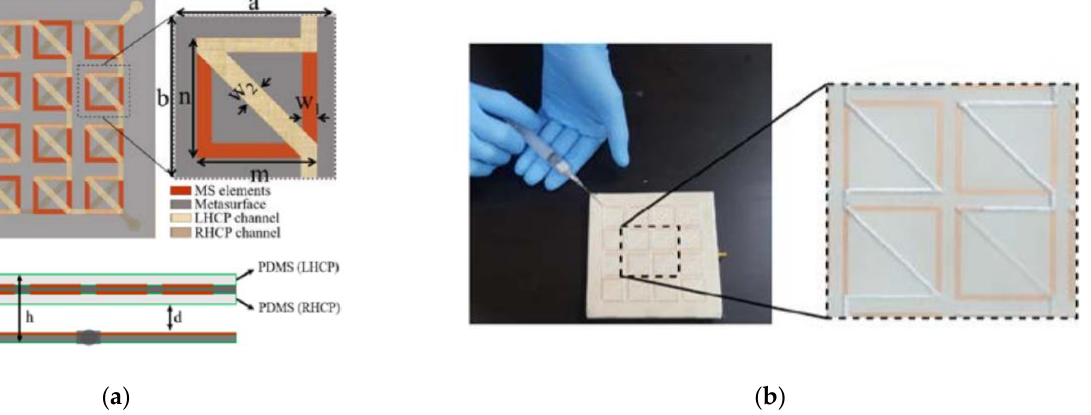
Figure 10. ( a ) MS-based polarizer with microfluidic channels (Reprinted, with permission [112]); ( b ) fabricated prototype (Reprinted, with permission [112]).